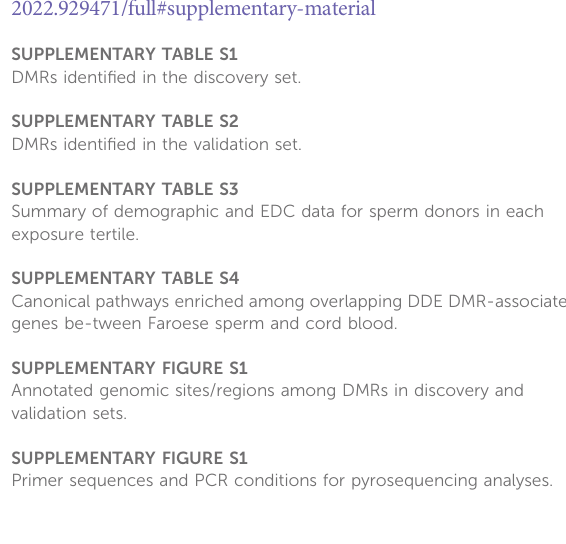
SUPPLEMENTARY FIGURE S1 Primer sequences and PCR conditions for pyrosequencing